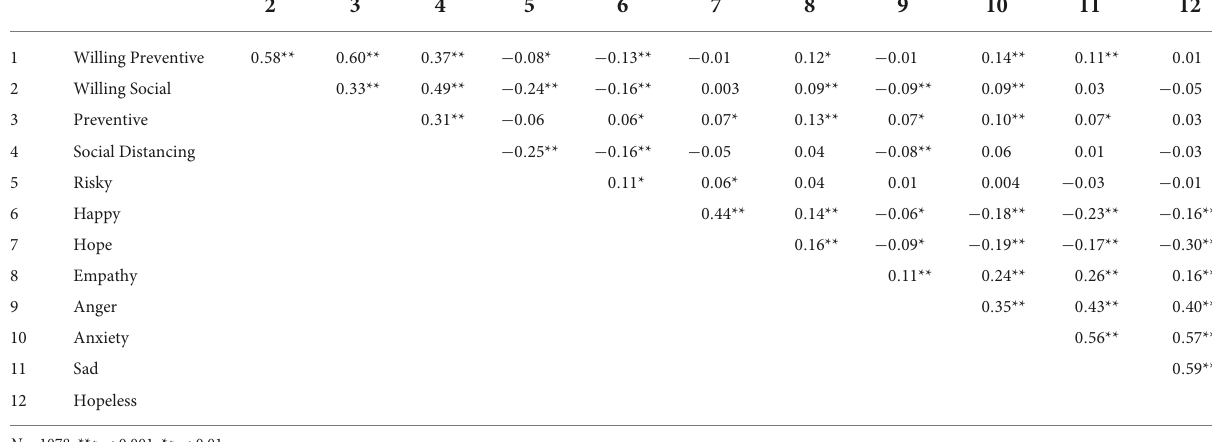
TABLE 3 Zero order correlations between variables.